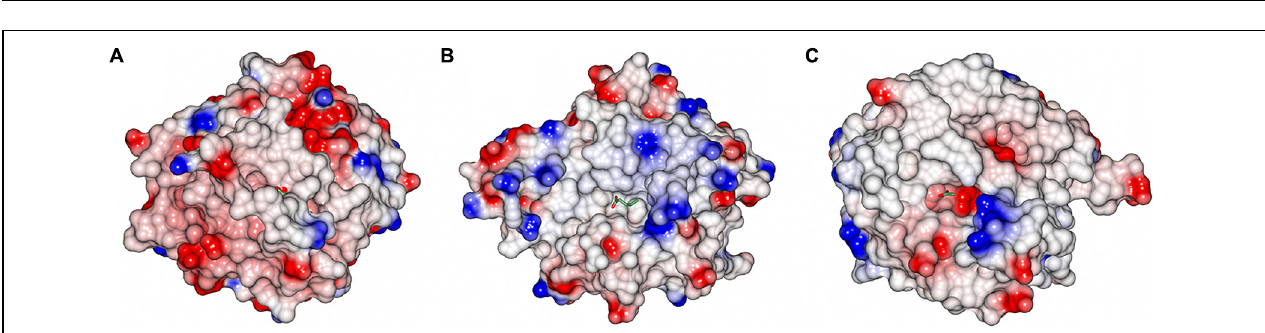
FIGURE 5 | (A) Stereo diagram showing the superimposition of the carboxyl binding pockets of the acetate (ACT) complex of the LpEst and the valerate complex of TtEst2 (VLT in green). The key residue side chains are shown as sticks models. Hydrogen bonding for the ligand in TtEst2 showing the three main chain nitrogen oxyanion hole is shown as black dashed lines. Figures 5 and 6 were prepared using CCP4mg (McNicholas et al., 2011). (B) Stereo diagram showing the superimposition of the 1-hexadecanesulfonyl (HDS) complex of the AaEst2 and the valerate complex of TtEst2 (VLT in green). The key residue side chains are shown as sticks and the hydrogen bonding for the valerate substrate in TtEst2 as black dashed lines.